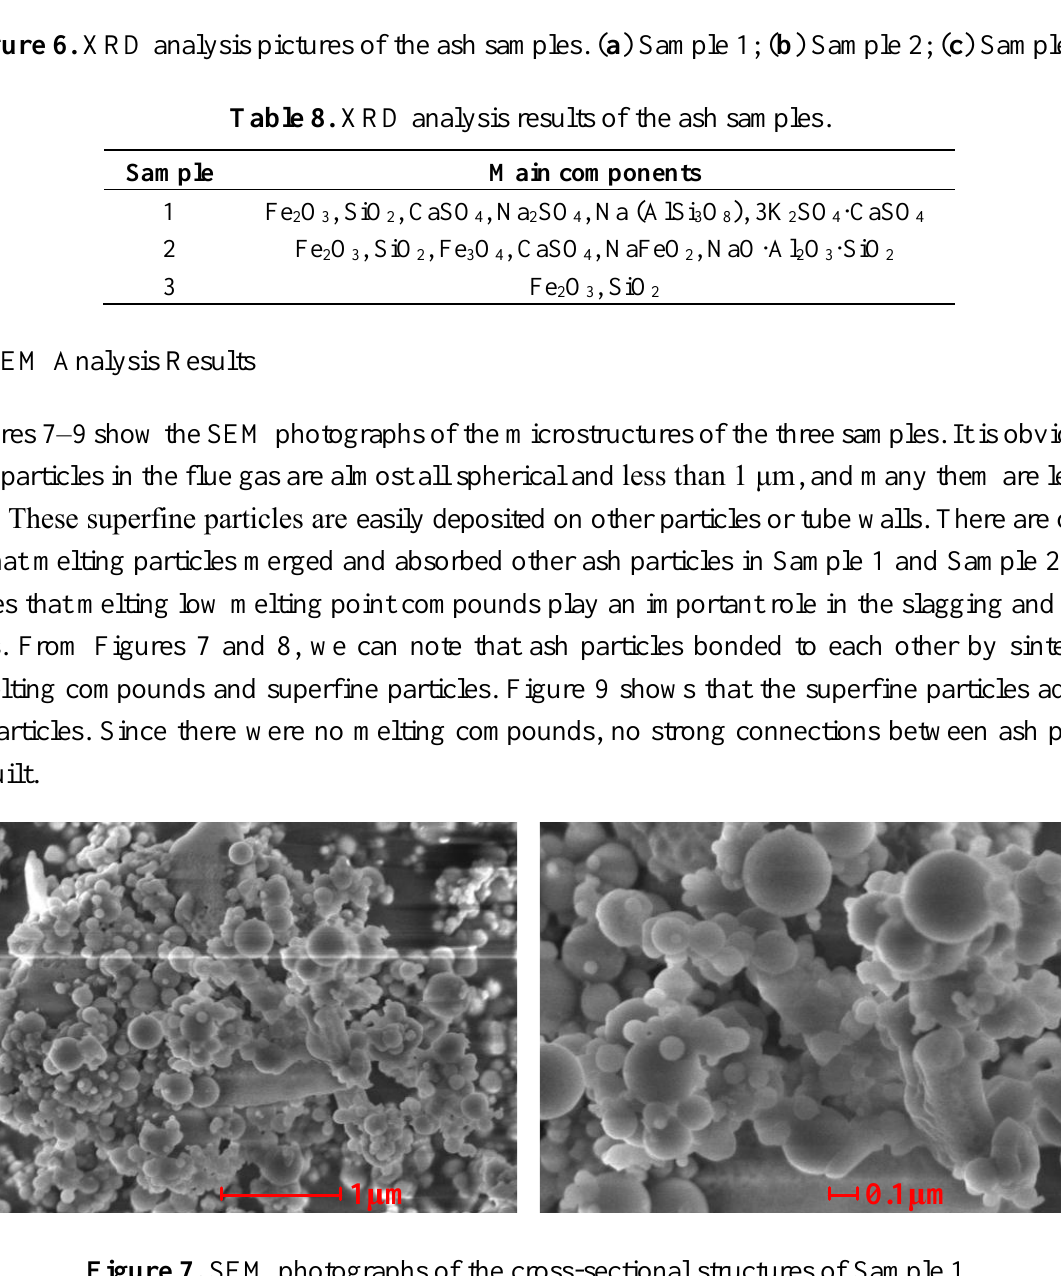
Figure 7. SEM photographs of the cross-sectional structures of Sample